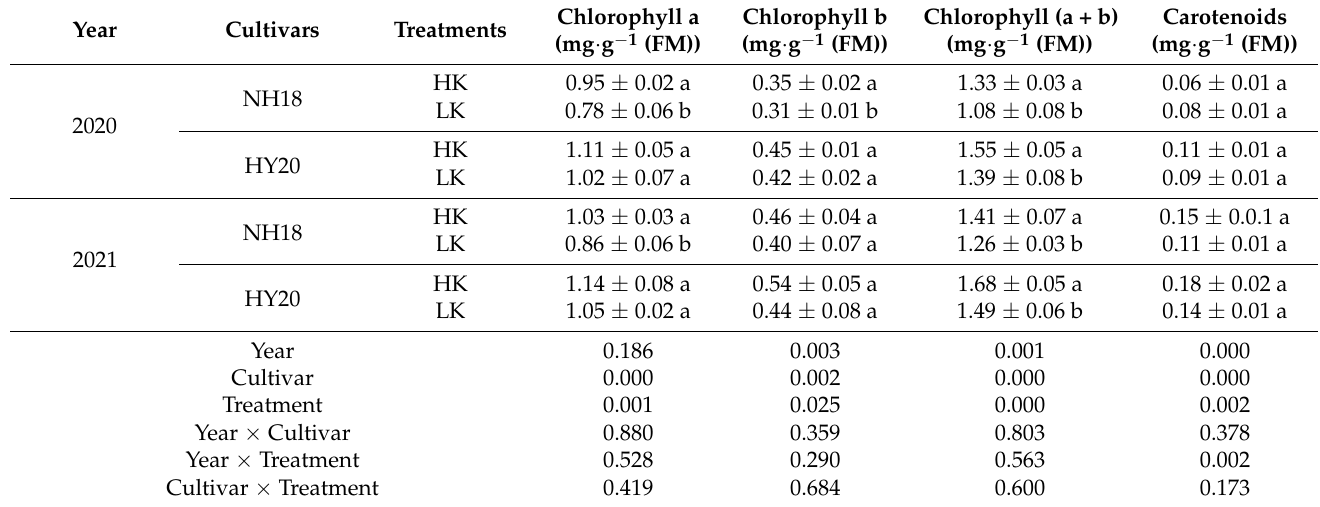
Table 3. Effects of low K stress on chlorophyll content in leaves.